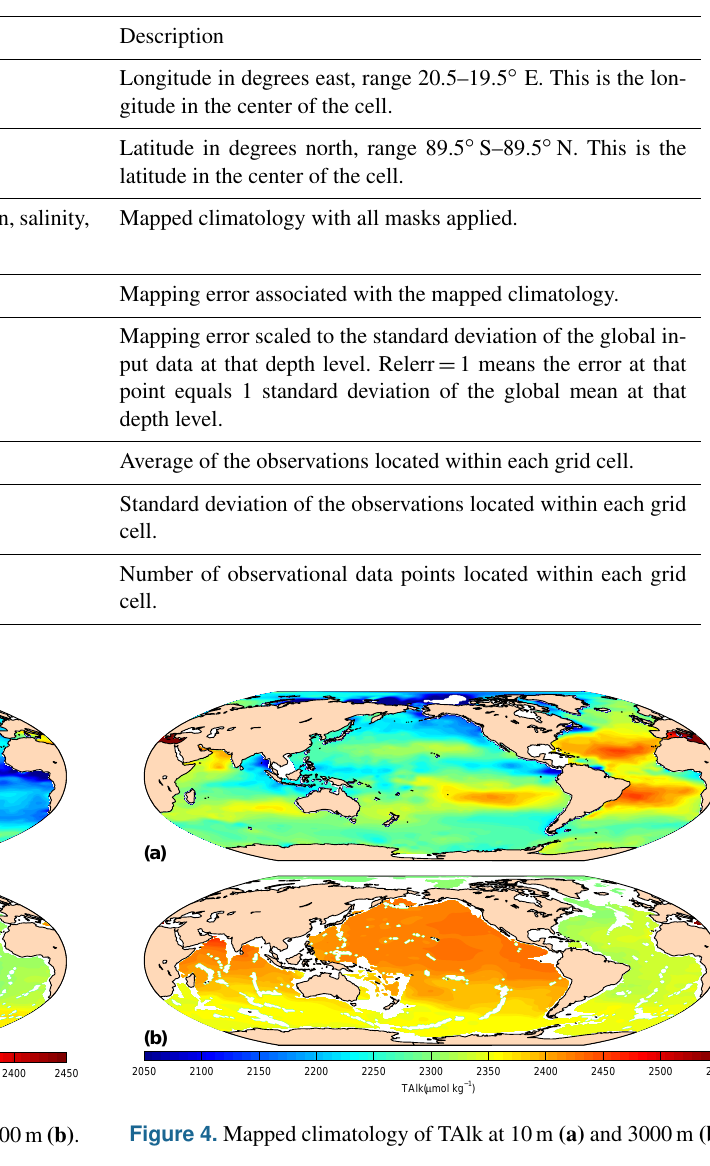
Table 2. List of information available in the netCDF data files.